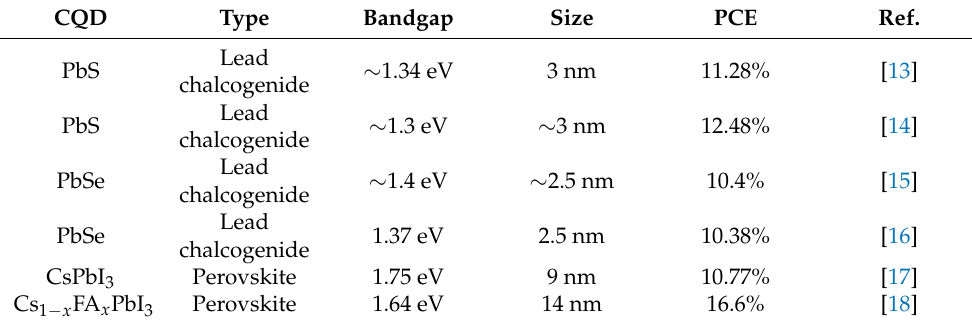
Table 1. Examples of CQD solar